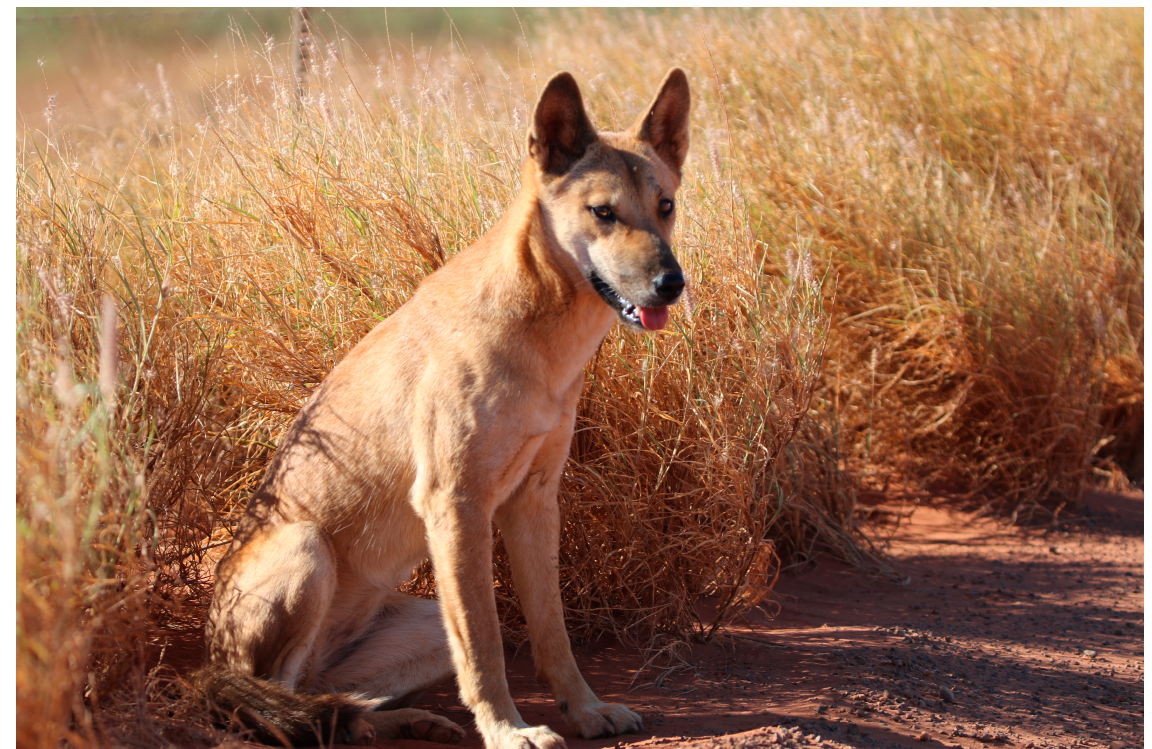
Figure 6. A wild dingo living on a remote mine site in the Tanami Desert. Dingoes are attracted to the rich food waste at rubbish tips and other scavenging opportunities generated by mining operations. Some of the dingoes can easily tolerate being in proximity to humans, in this case allowing the photographer to come close enough to it to take this shot. Credit: Thomas